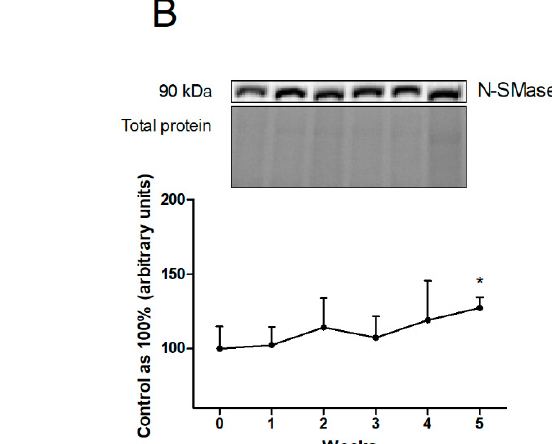
Figure 3. The expression of proteins from the sphingolipid catabolism pathway, i.e., ( A ) sphingosine kinase 1 (SPHK1), ( B ) sphingosine kinase 2 (SPHK2), ( C ) acid ceramidase (ASAH1), ( D ) neutral ceramidase (ASAH2), and ( E ) alkaline ceramidase (ASAH3) in the liver homogenates. The protein expression was measured using the Western blot technique and presented as a percentage difference compared to the control group, which was set as 100%. The data are presented as mean ± SD and based on n = 6 rats per group in each week of the high-fat diet (HFD). * p < 0.05 significant difference vs. control group (0 week).